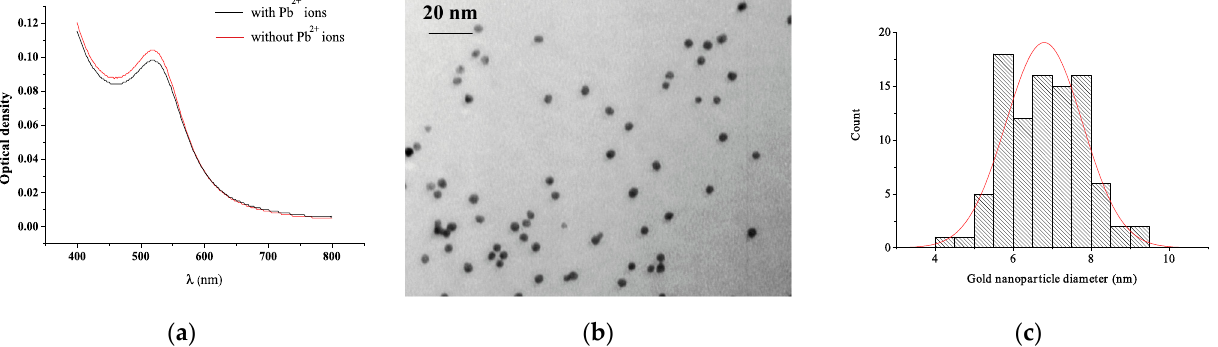
Figure 1. ( a ) Absorbance spectra of TA-capped AuNPs with (black lines) and without (red lines) Pb 2+ ions. ( b ) TEM image and ( c ) histogram of diameter distribution of the obtained TA-capped AuNPs.